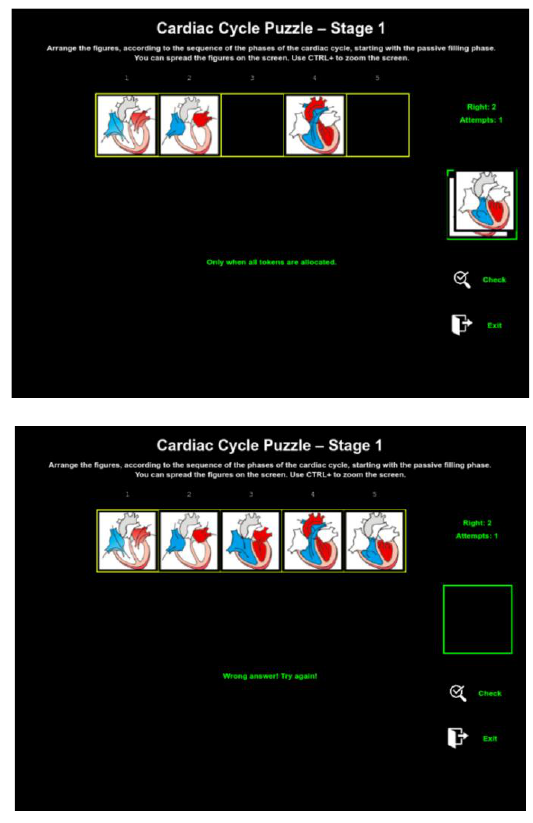
Figure 5. Stage 1 of the online digital cardiac cycle